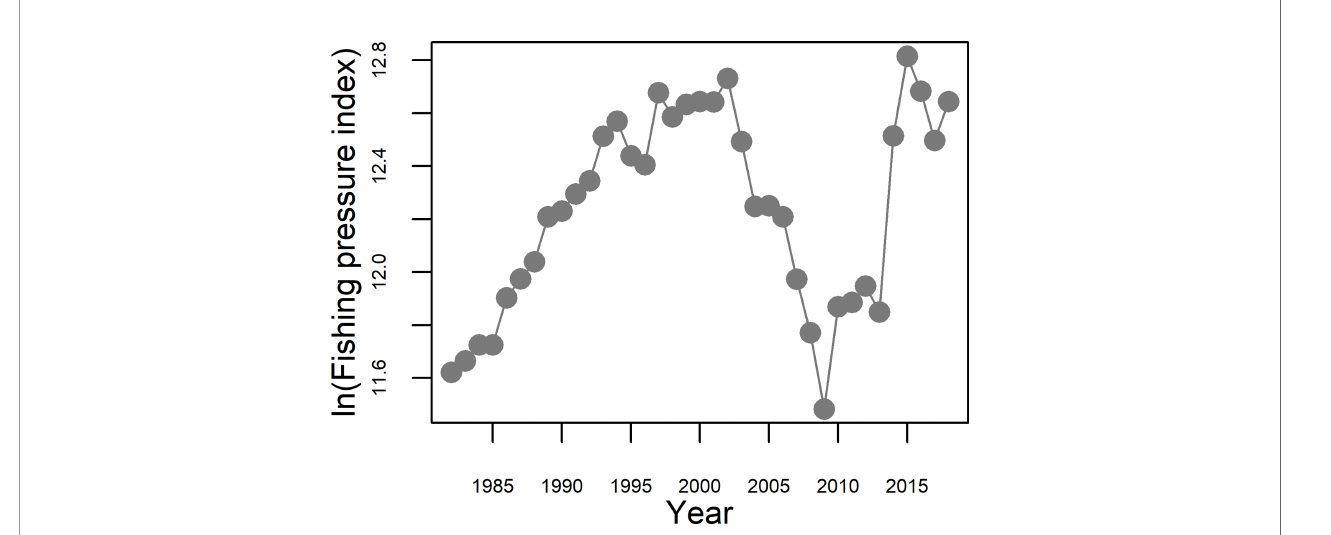
FIGURE 8 | Changes in the proxy of fi shing pressure (in ln(Fishing pressure index)) in the Bohai Sea during the period 1982 −